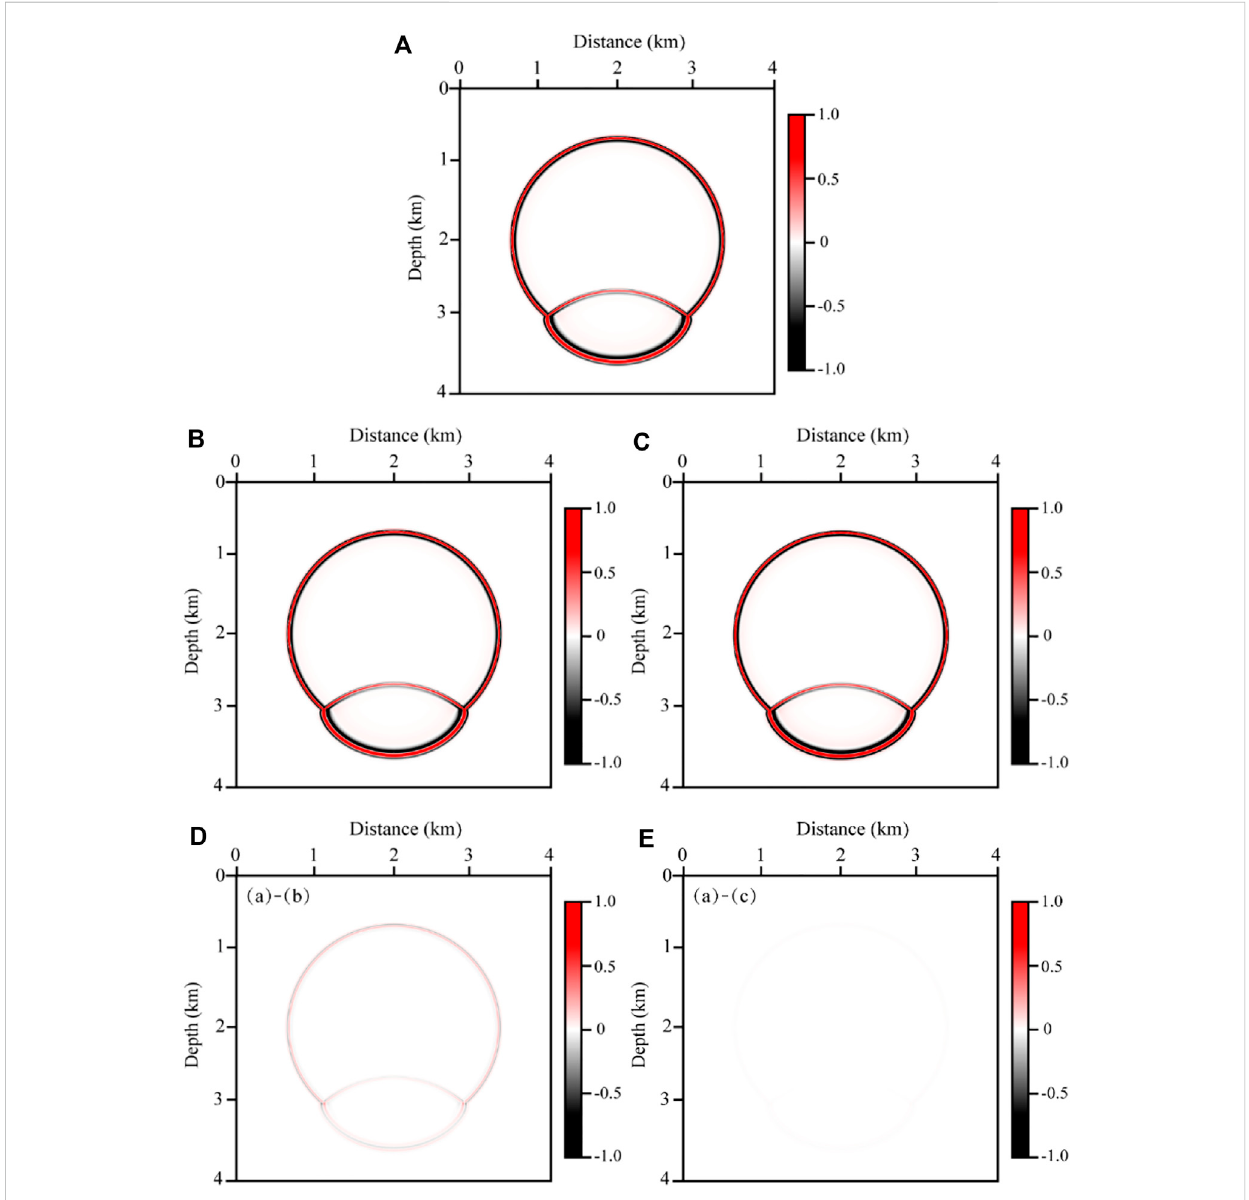
FIGURE 4 Wave fi eld snapshots at 700 ms for the two-layer models. (A) the reference solution, (B) the average Q scheme. (C) the constant-order scheme (D) the difference between the reference solution and average Q scheme (E) the difference between the reference solution and constant-order